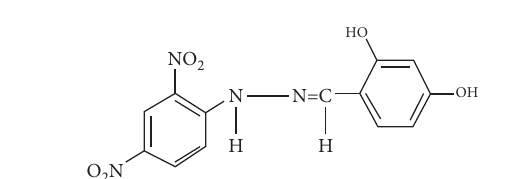
Figure 2: Chemical structure of DBH6 (compound 6) [4-(2-(2, 4- dinitrophenylhydrazono) methyl) benzene-1,